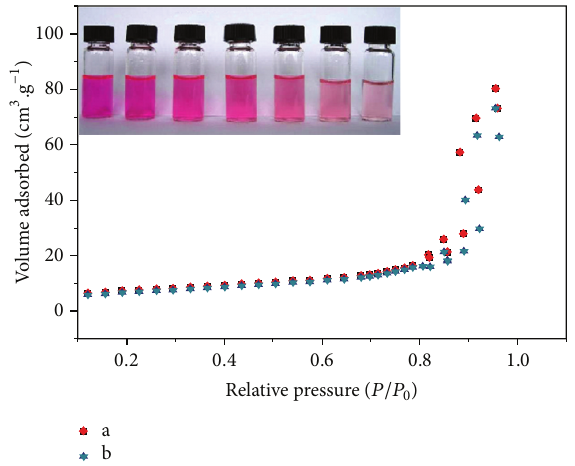
Figure 6: Typical nitrogen adsorption isotherms of as-prepared ZnWO 4 : (a) 140 ∘ C and (b) 160 ∘ C. Inset: Effect picture of photocat- alytic degradation RhB by ZnWO 4 prepared at 140 ∘ C for 5min.